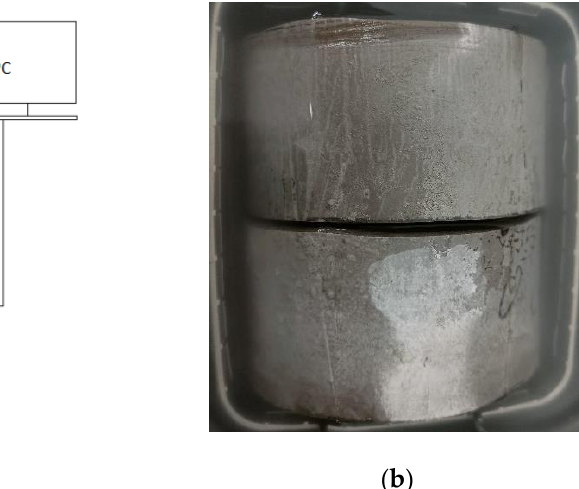
Figure 10. The acceleration equipment and the test specimen: ( a ) equipment; ( b ) test specimen.